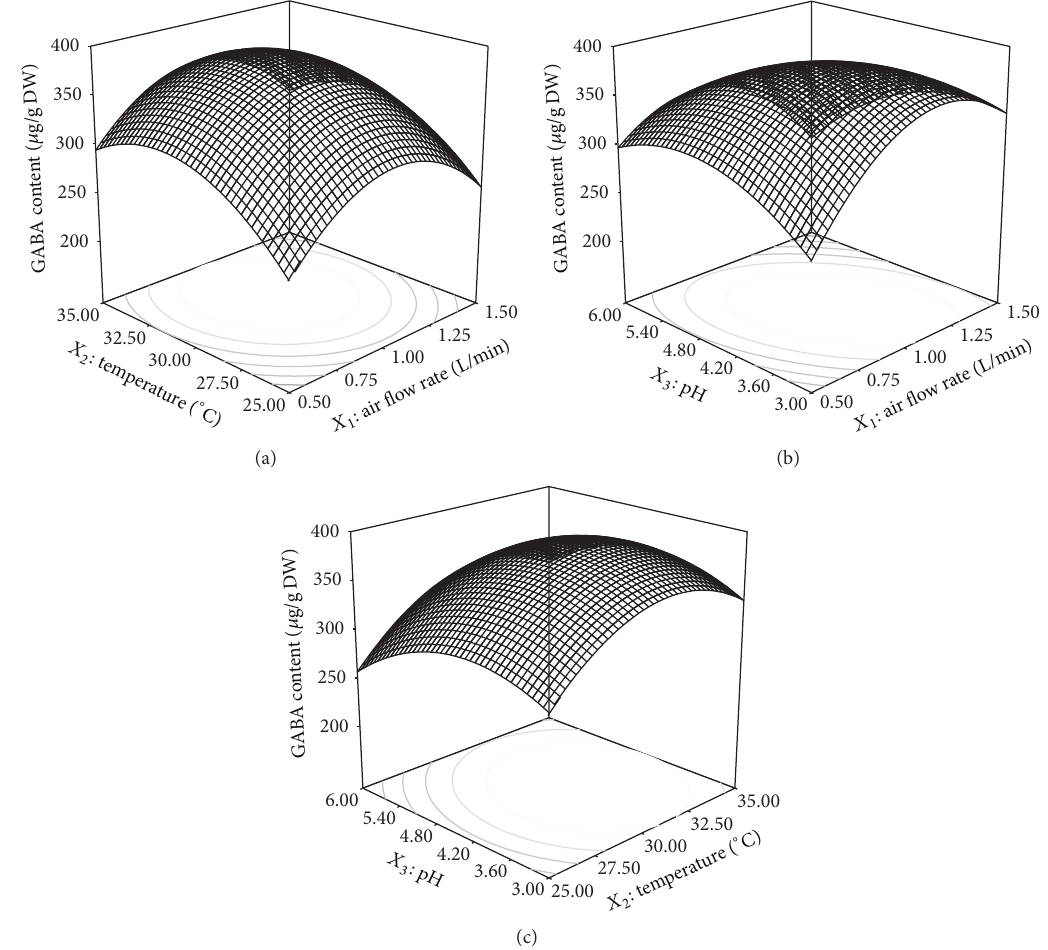
Figure 4: Effect of interaction between pairs of variables on GABA content: (a) air flow rate 1.0L/min; (b) pH 4.5; (c) temperature 30 ∘